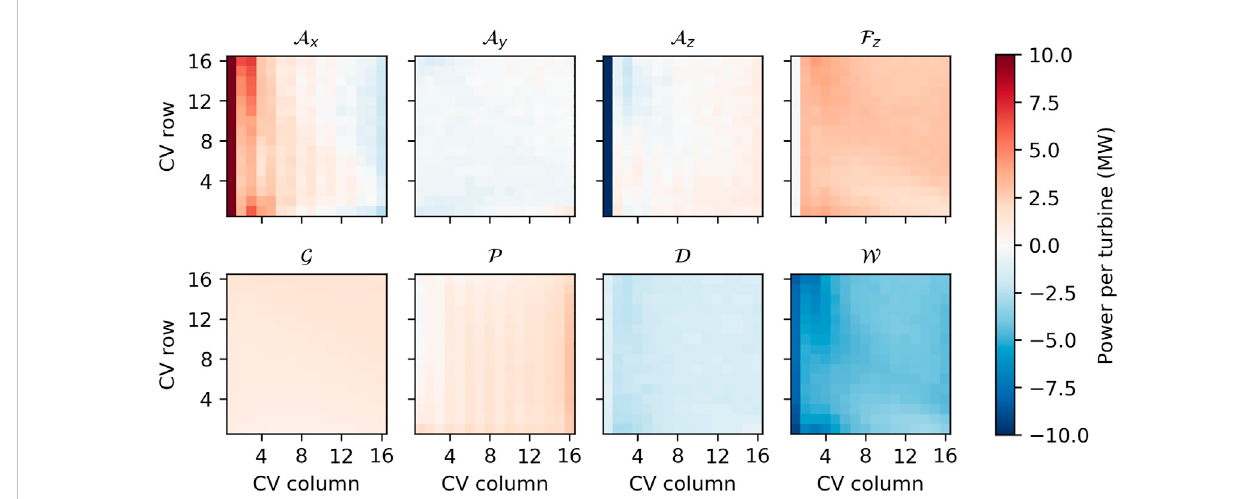
FIGURE 8 Energy budgets inside the wind turbine control volumes (CVs) Ω wt . The budget terms are: advection of KE through left/right ( A x ) , south/north ( A y ) and bottom/top ( A z ) boundaries, turbulent fl uxes through bottom/top boundaries ( F z ) , geostrophic forcing ( G ) , perturbation pressure gradients ( P ) , dissipation ( D ) and energy extraction by wind turbines ( W ) . The buoyancy term ( B ) and the horizontal turbulent fl uxes ( F x and F y ) are not shown, because they are very small (see Figure 7). The values of A x and A z in the fi rst CV column are larger than the color scale range, see Figure 9.